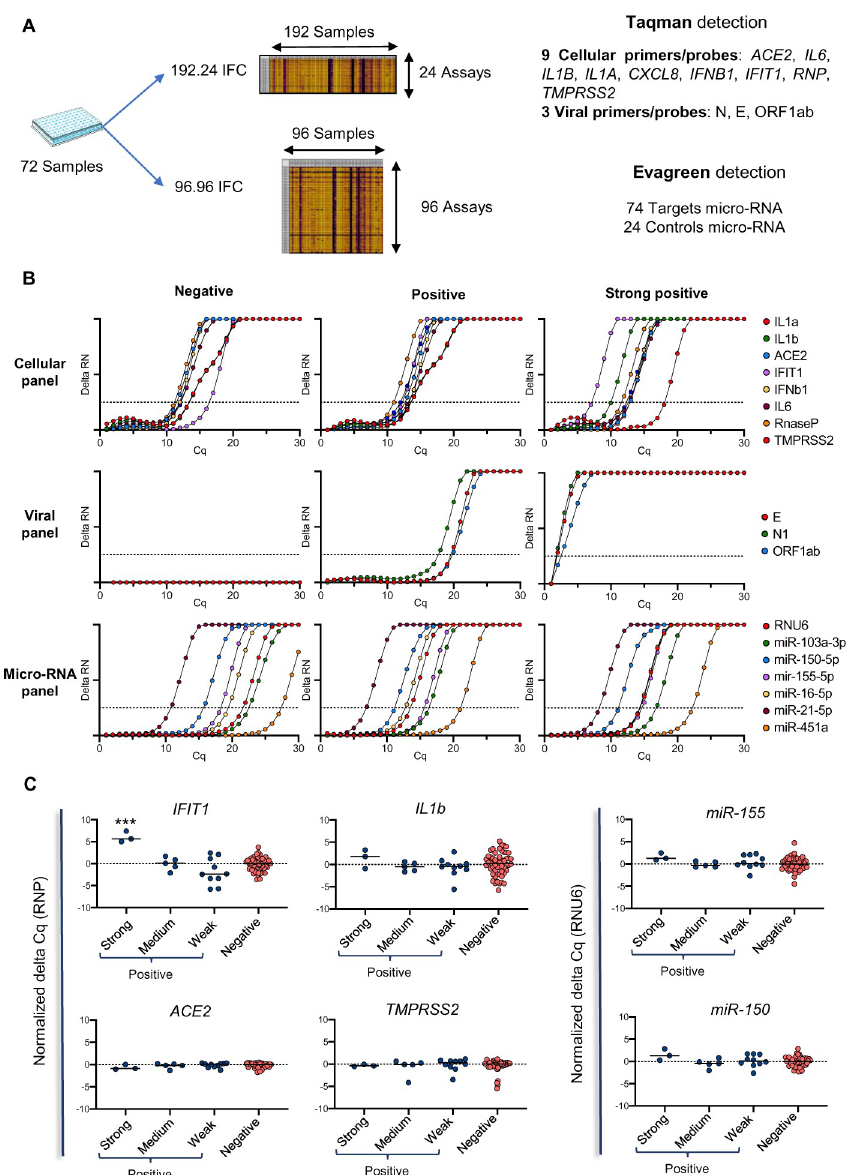
Fig 3. Use of the Biomark-based protocol to analyze the host response to SARS-CoV-2 infection at the mRNA and microRNA levels. (A) Overview of the analysis strategy on 72 patient samples. They were divided into 4 groups, according to their viral load, from negative, weak (Cq for viral probes > 20), medium (20 > Cq for viral probes > 10) and strong (Cq for viral probes < 10) SARS-CoV-2 positive. (B) Typical amplification curves of the different genes (cellular, viral and micro-RNA) on three different SARS-CoV-2 patient status. (C) Modulation of cellular markers in the different groups of patients according to their SARS-CoV-2 viral load. IFIT1 expression was statistically elevated (p < 0.001) in the strong COVID-19-positive samples compared to the three other groups considered separately. The Cq presented are representative of two independent experiments performed in quadruplicate. detergent widely used for inactivation of enveloped viruses such as SARS-CoV [22, 23]. We first compared a regular extraction-based method with a direct RT-qPCR protocol on a syn- thetic N transcript spike in TE buffer in the presence or the absence of 0.5% Triton X-100 and confirmed that Triton X-100 did not interfere with the efficiency of the RT-qPCR steps (S4A